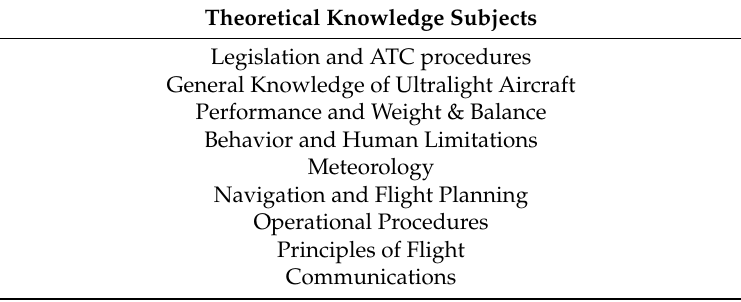
Table A1. Theoretical training requirements for Portuguese ultralight pilots.